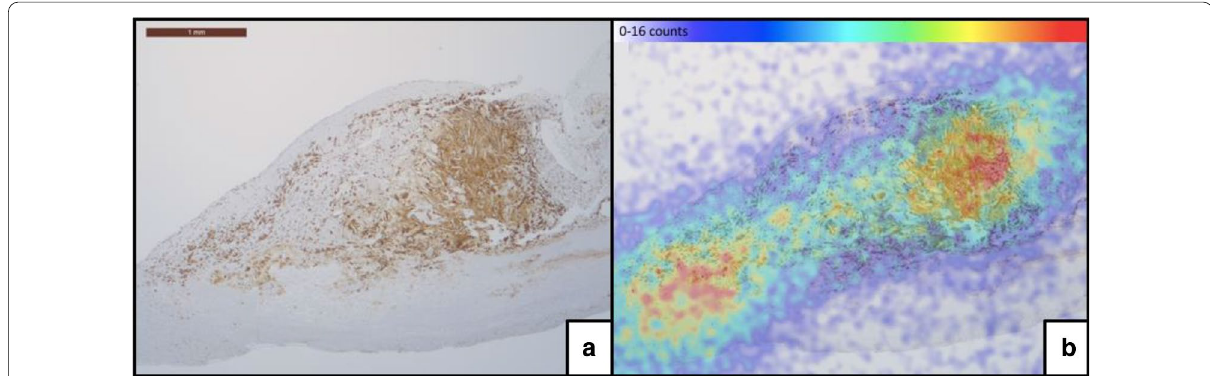
Fig. 3 Co‑localization of [ 18 F]‑PBR06 and CD68 macrophages. a CD68 immunohistochemistry. b fused image of [ 18 F]‑PBR06 micro‑imaging and CD68 staining